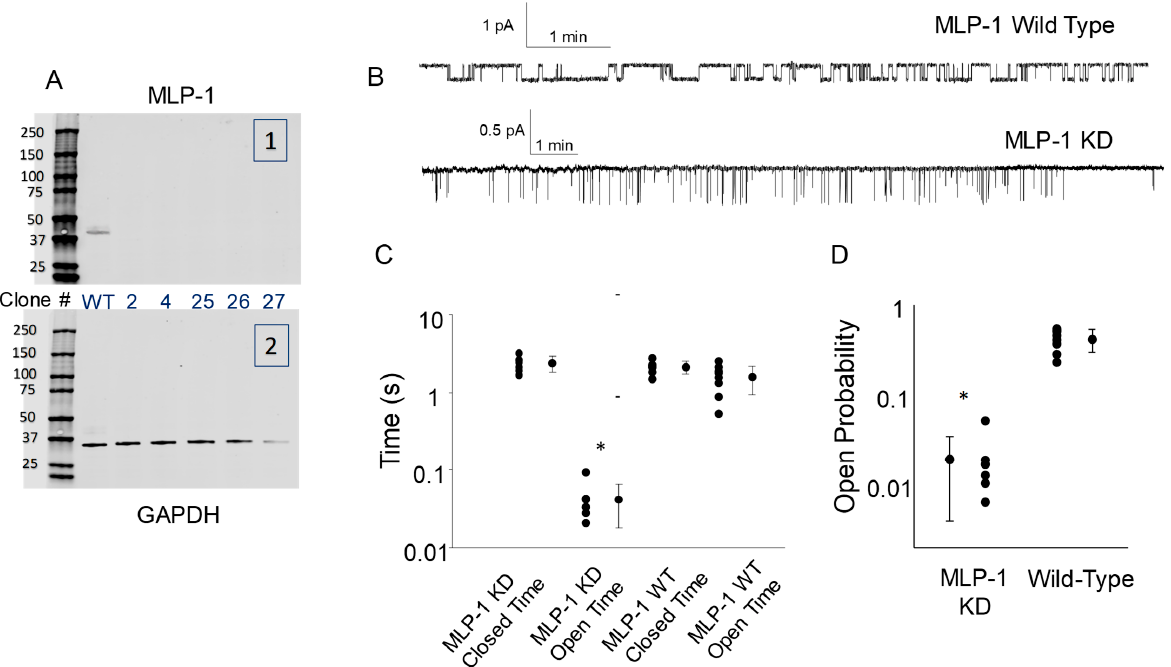
Figure 9. ENaC activity is greatly reduced in mpkCCD cells in which MLP-1 is strongly knocked down. Using CRISPR/Cas9, MLP-1 was knocked down between five and seven cycles (by Q PCR), implying at least a 30 to 120-fold reduction in MLP-1 in several clones. Western blots of wild-type and five knockout clones are shown in ( A ) blotted for MLP-1 (in 1) or GAPDH (in 2). MLP-1 is below detection limits. Full Western blot images are presented in supplementary data. In ( B ), single channel traces show that only short, flickery channel events are observed in the KO cells (lower trace) compared to the wild type (upper trace). Many of the events in the knockdown trace are so short that they do not reach full amplitude due to filtering (at 100 Hz). ( C ) shows that the major effect of the knockdown is to reduce the mean open time in the KD cells. The mean open time is significantly different from all other mean times (* indicates significant difference p < 0.05). As expected in Panel ( D ), the reduced mean open time leads to a dramatically reduced open probability (* indicates significant difference p < 0.001). Symbols represent values for individual